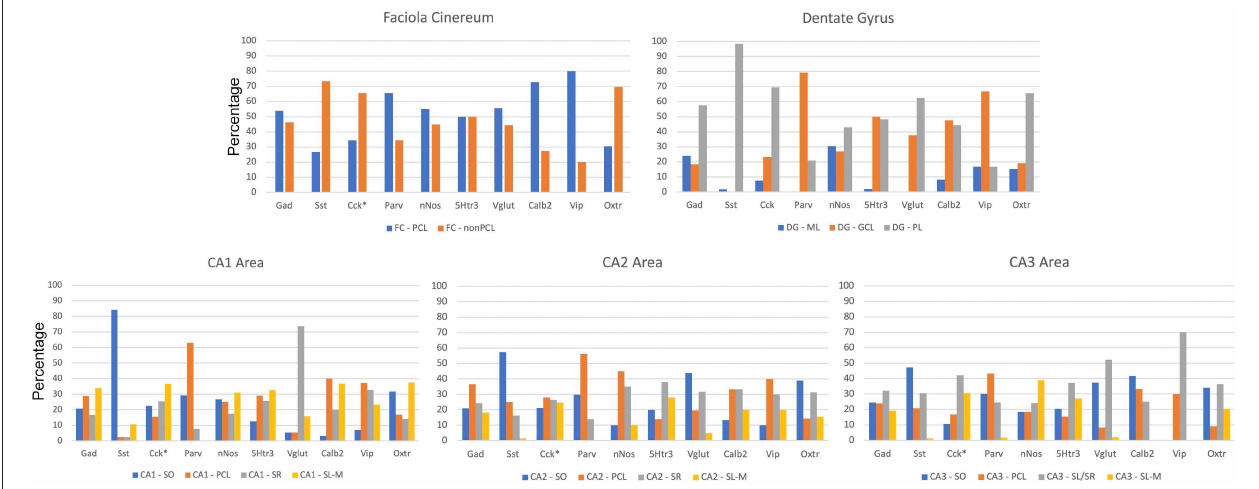
FIGURE 10 | Distribution of interneurons in sublayers of the hippocampus by region by percentage. *Cck and Oxtr neurons in the PCL of FC, CA2, and CA3 were counted if they co-expressed Gad-1. GCL, granule cell layer; ML, molecular layer; PCL, pyramidal cell layer; SL/SR, stratum lucidum/radiatum; SL-M, stratum lacunosum-moleculare; SO, stratum oriens; SR, stratum